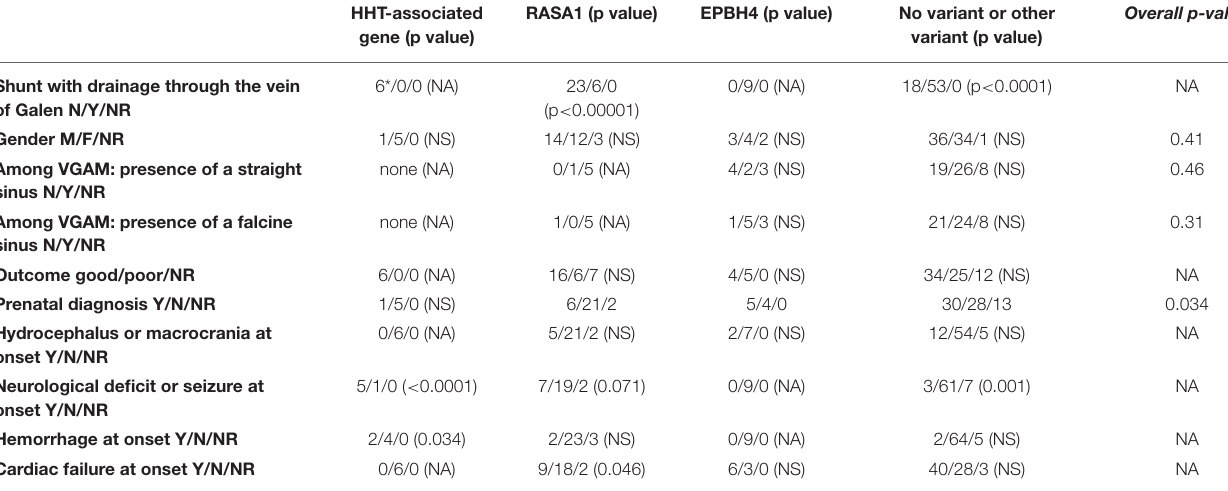
TABLE 2 | Clinical data of patients at presentation and phenotype-genotype correlation, with p